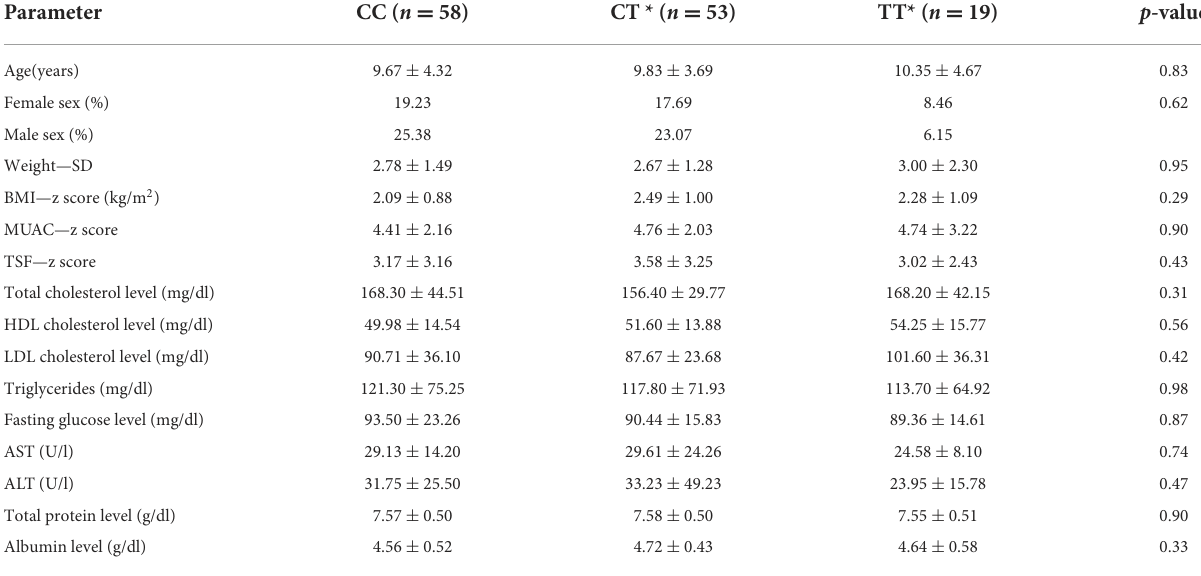
TABLE 5 Comparison of demographic, anthropometric, metabolic, and paraclinical data of the overweight/obese group divided in accordance with genotype distribution of PPARGC1A rs8192678 SNP.